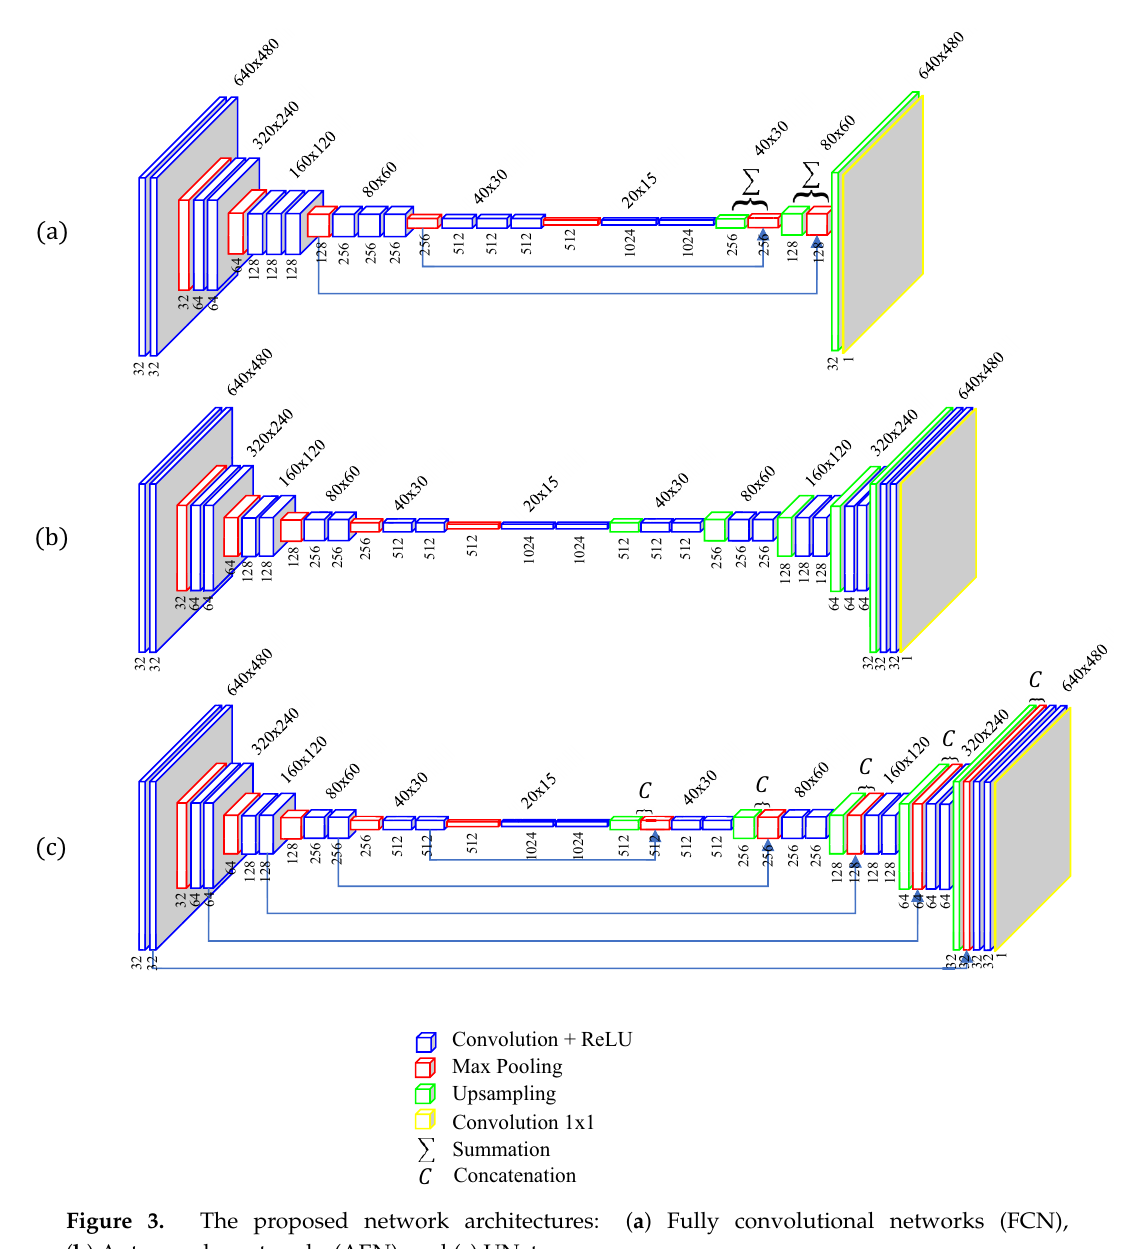
Figure 3. The proposed network architectures: ( a ) Fully convolutional networks (FCN), ( b ) Autoencoder networks (AEN), and ( c )